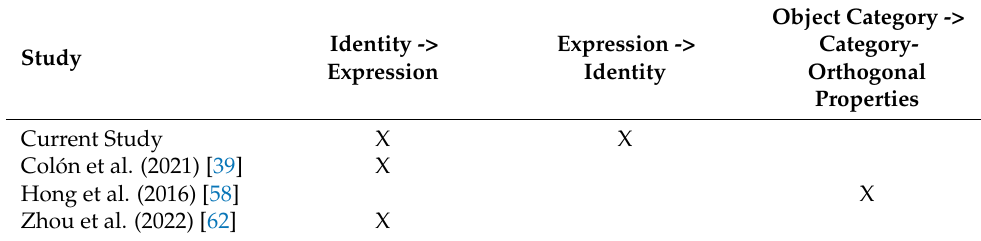
Table 3. Comparison of studies evaluating different DCNN generalizations.